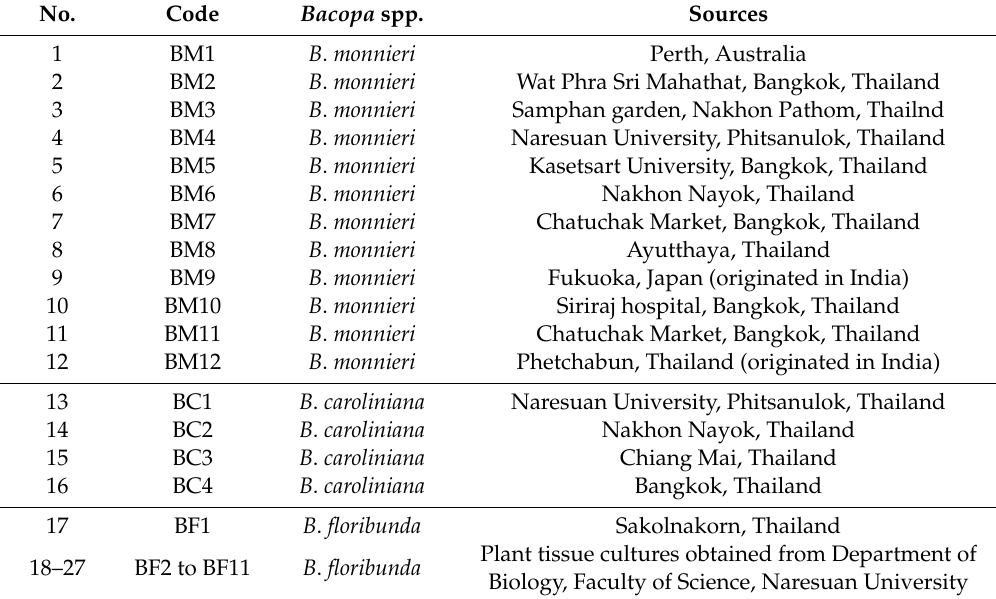
Table 3. The geographical details of the Bacopa samples collected in this study. Samples 1–16 were collected in 3 seasons i.e., winter, summer, and rainy season (48 samples). Only sample 17 was collected in summer (1 sample). Plant tissue cultures of B. floribunda (samples 18–27) were collected in April, 2017 (10 samples).